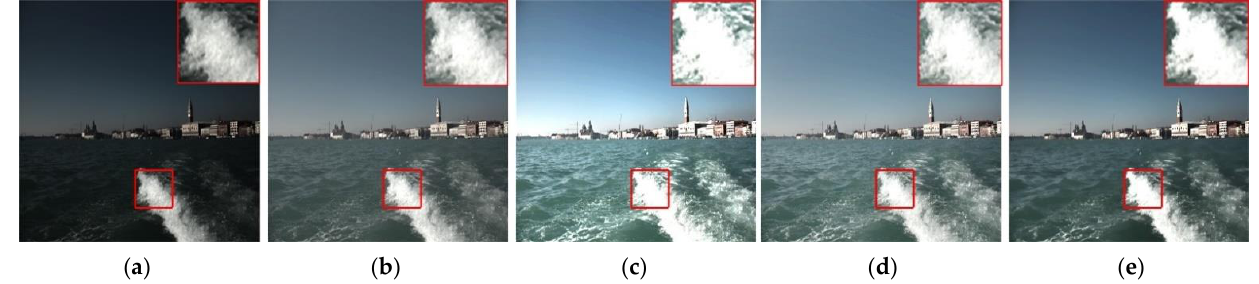
Figure 5. Experimental results of several methods in the brighter areas of the image. ( a ) Original image; ( b ) BIMEF; ( c ) LIME; ( d ) LECARM; ( e ) SDD.